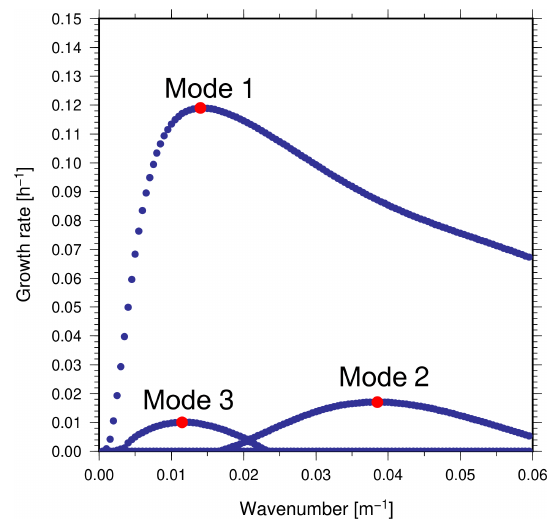
Figure 4. Growth rates as a function of the wavenumber for H rms = 1 . 5m and T = 10s. The bathymetry considered in this case is the same as presented in Fig.